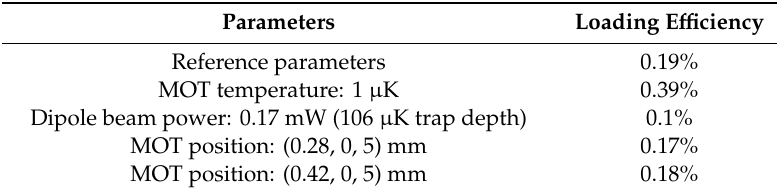
Table 2. Atom loading e ffi ciency with di ff erent parameters. The first row refers to the parameters from Table 1, and the other rows di ff er from the first row by the parameter indicated.